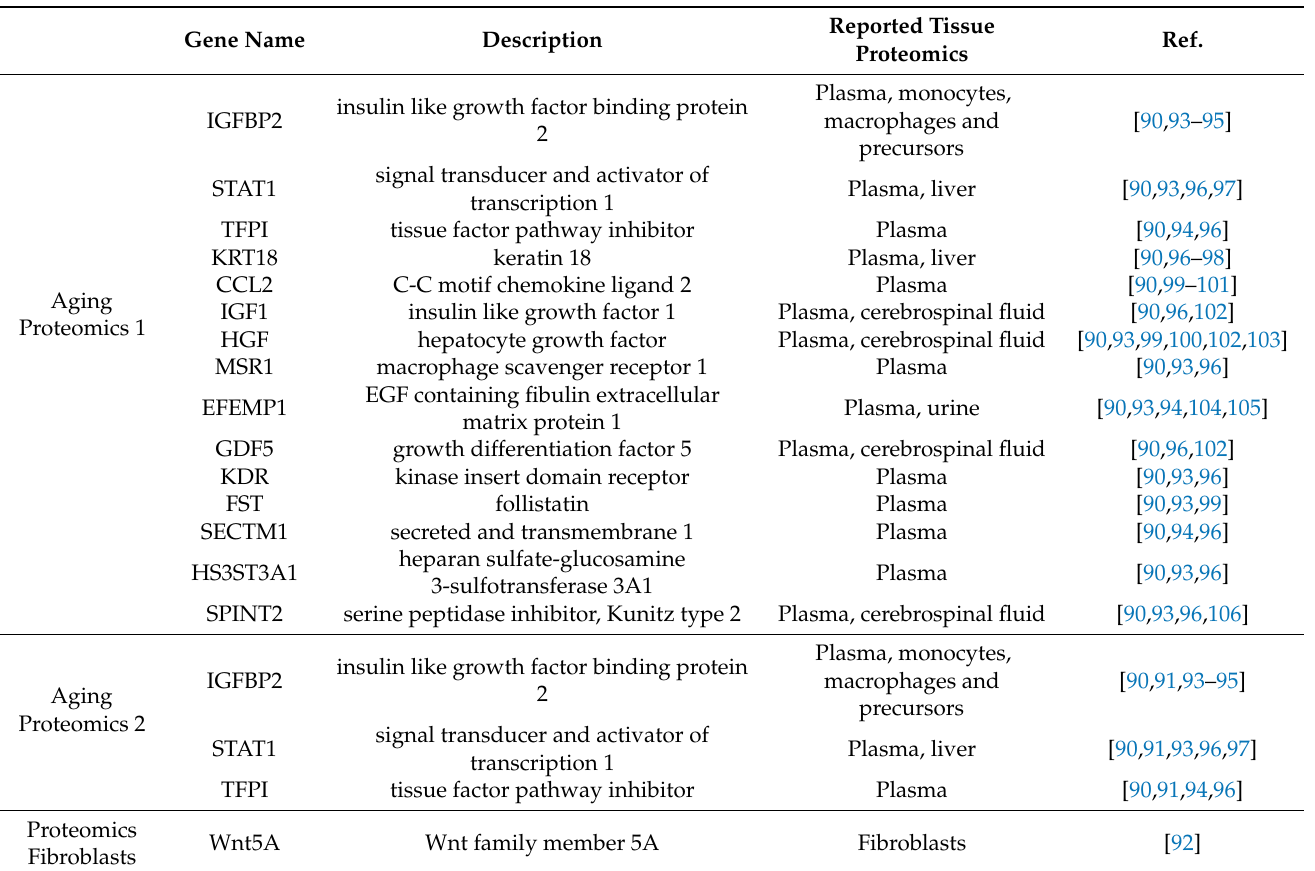
Figure 14. Venn diagram analyses of progeria and aging in our RNA-Seq results and proteomics literature. ( A ) The DEGs of the aging comparison (blue) and the DEGs of the progeria comparison (yellow) compared with the proteins of the proteomics analyses reviewed by Johnson et al. (2020; available in their Supplementary Material [90] ; green). ( B ) The DEGs of the aging comparison (blue) and the DEGs of the progeria comparison (yellow) compared with the proteins of the proteomics analyses reviewed by Moaddel et al. (2021; available in their Supporting Information [91] ; green). ( C ) The DEGs of the aging comparison (blue) and the DEGs of the progeria comparison (yellow) compared with the proteins of the proteomics analyses by Tsitsipatis et al. (2022; available in their Supporting Information [92] ; green). Table 2. Cross check of the genes regarding the common genes in aging and progeria in our RNA-Seq analysis and aging-related/progeria-related proteomics publications.